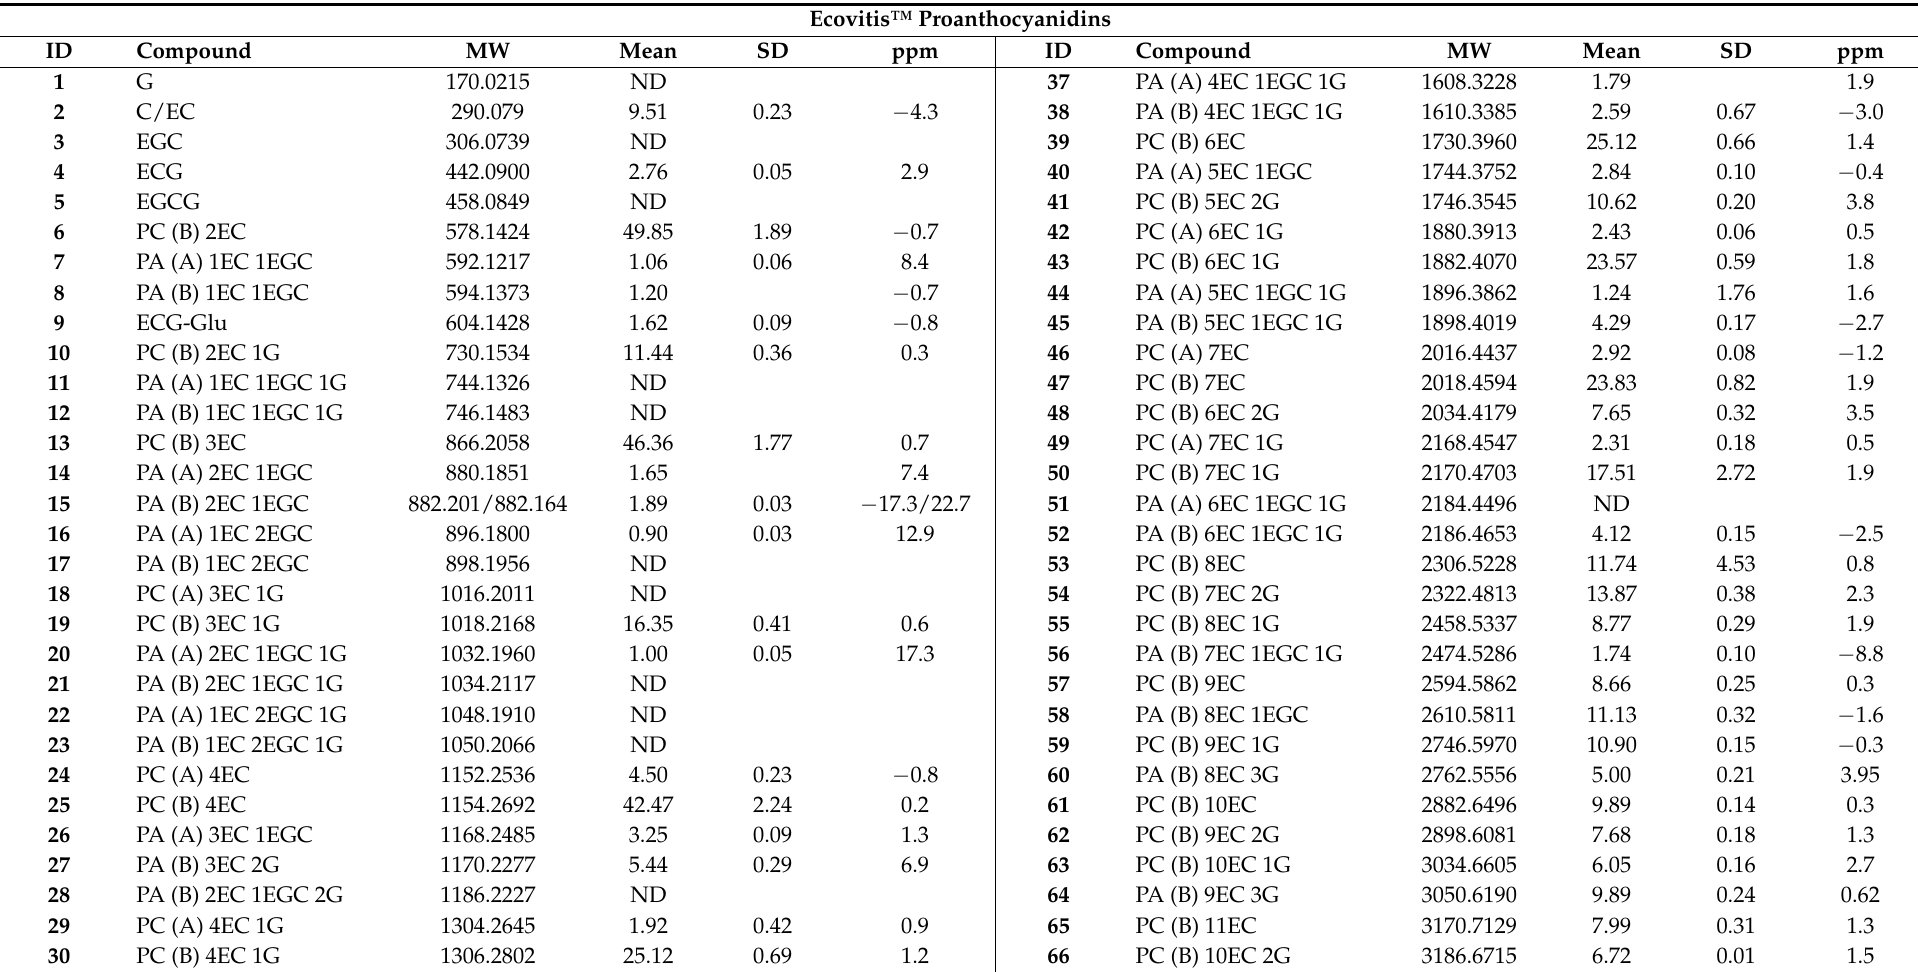
Table 2. Proanthocyanidins identified in Ecovitis™ by LC-Chip/ESI-Q-TOF–MS analysis performed in the negative ion mode. The concentration of compounds, as µ g/mg of extract, are the average obtained from triplicate